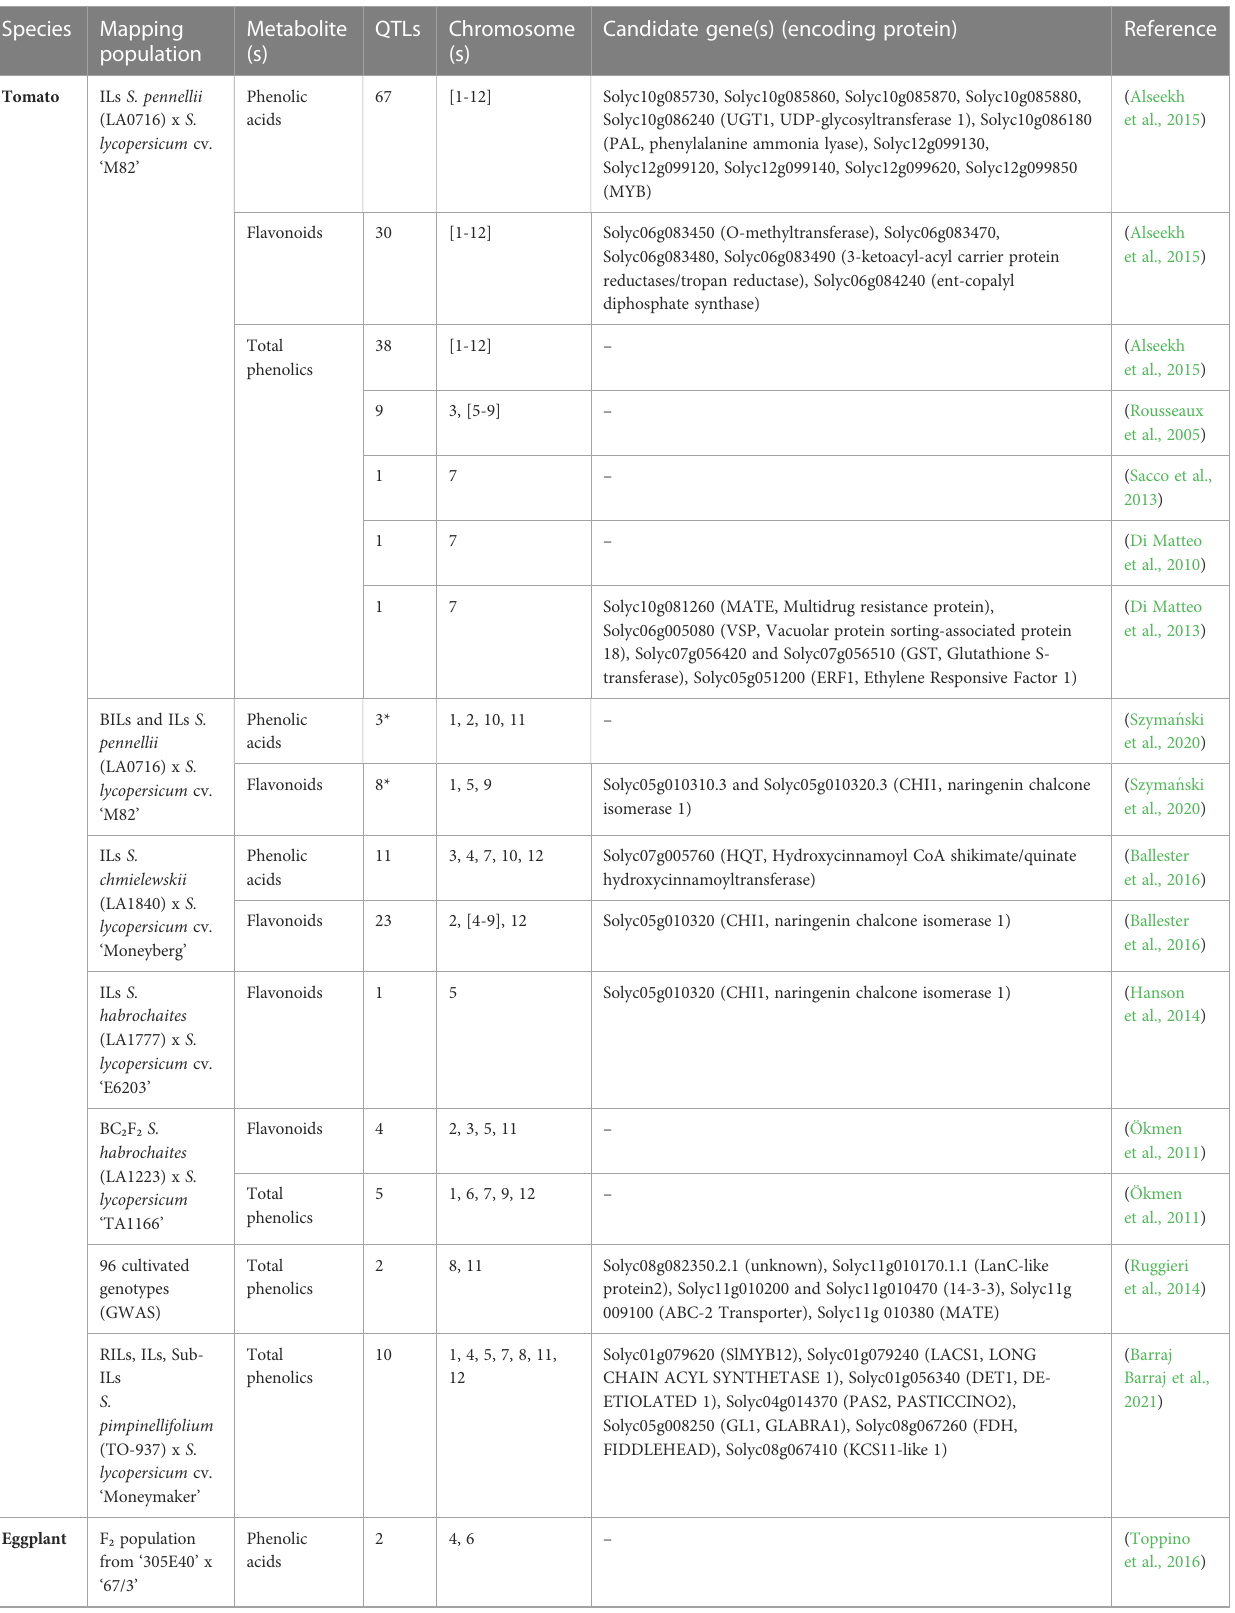
TABLE 1 Number of QTLs associated with phenolic acids, fl avonoids (other than anthocyanins) and total phenolics content for tomato, eggplant and